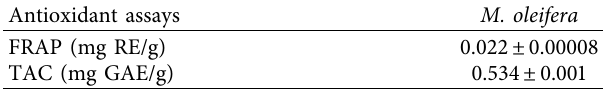
Table 2: Antioxidant activity of M. oleifera .